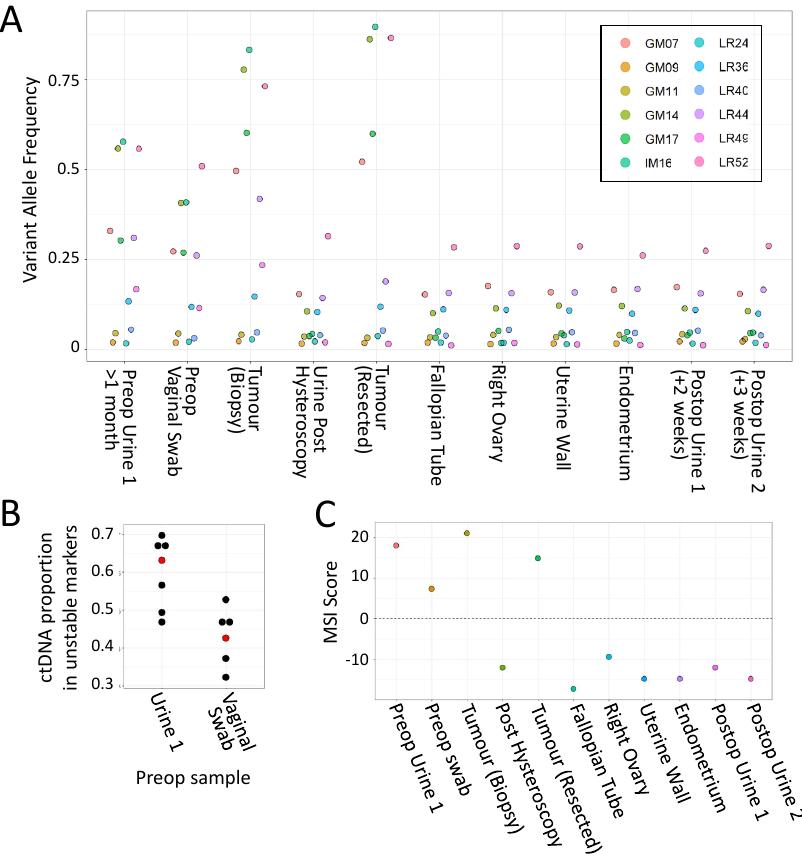
Figure 5. Analysis of Case 2 (LS EC patient) samples with the mPCR assay. ( A ) VAFs for all 12 markers in Case 2 samples. (key gives marker names) ( B ). Estimates of proportion of tumour-derived DNA within preop samples, based on 6 markers with increased VAFs. Median values are shown in red. ( C ) MSI classifier scores of all Case 2 samples. For details of samples, classifier scores, read/barcode numbers, and examples of marker allele distributions, see Table S3 and Figure S7.